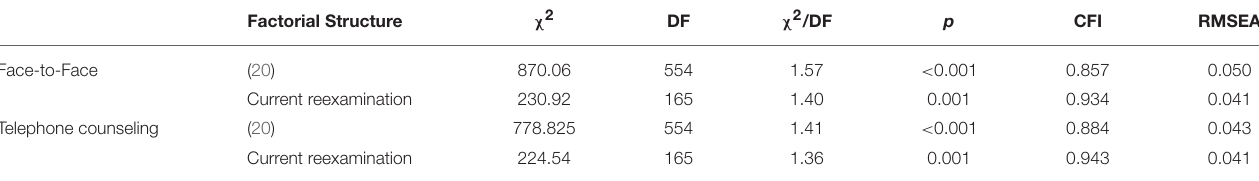
TABLE 1 | Summary of CFA indexes under assessment.